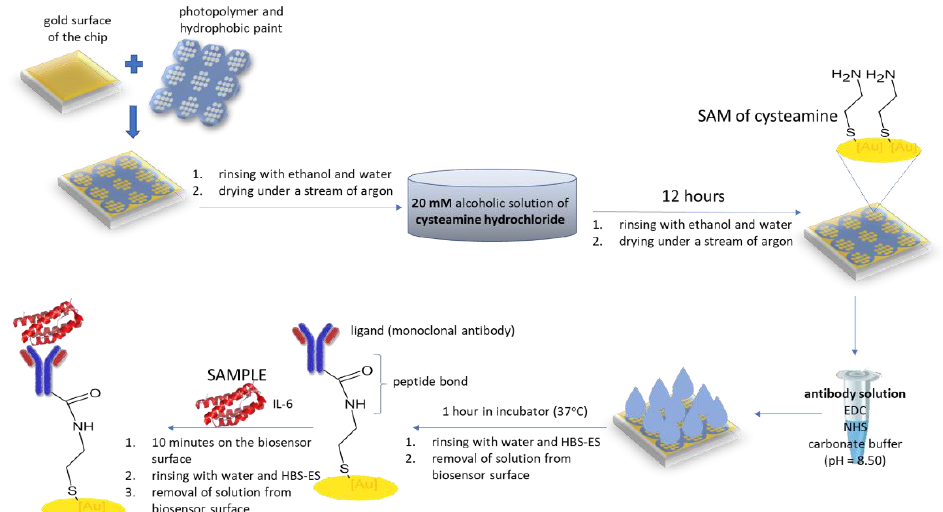
Figure 1. Workflow of the formation of a biosensor (a) with mouse monoclonal anti-IL 6-antibody as the receptor.